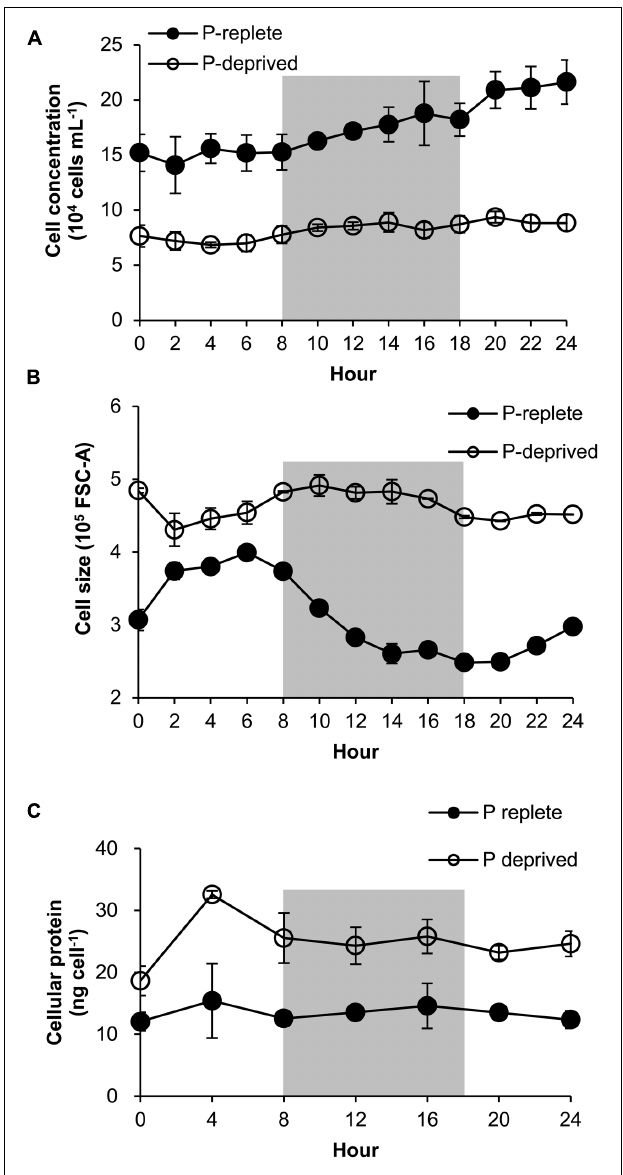
FIGURE 5 | Growth curve (A), cell size (B), and protein content (C) of A. carterae in a 24-h diel cell cycle. Cell size values in (B) are forward scatter values as proxies. Gray shading indicates dark period. Shown are means ± standard deviations (error bars) from the triplicated cultures. Statistically significant difference was found between the two P treatment groups in all cases ( p <